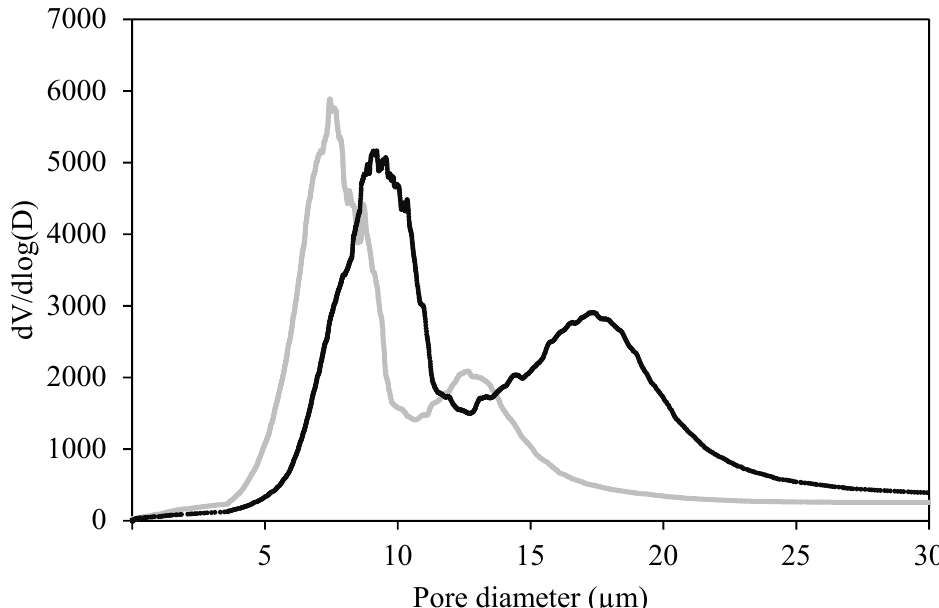
Figure 4. Exemplary plot for the pore size distribution obtained by mercury porosimetry, where the grey line corresponds to sample 4 (cooling rate (CR) = 1.01 ◦ C/min, scraping speed (v) = 150 rpm, number of temperature cycles (NTC) = 2, thickness of the frozen cake ( δ cake ) = 10 mm) and the black line corresponds to sample 23 (CR = 0.58 ◦ C/min, v = 150 rpm, NTC = 6, δ cake = 10 mm). The modal pore diameter d M,1 describes the first peak (smaller pores), the modal pore diameter d M,2 describes the second peak (bigger pores).